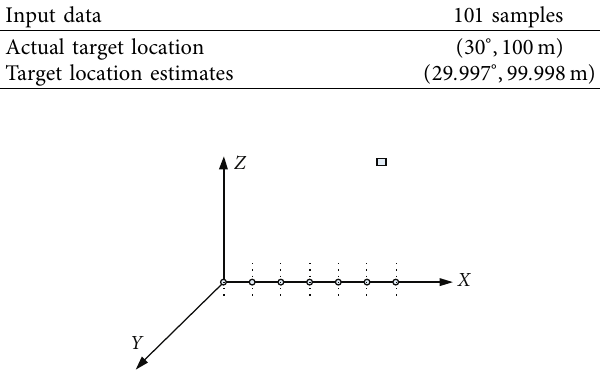
Figure 9: The model of antenna array in the FEKO simulation environment.